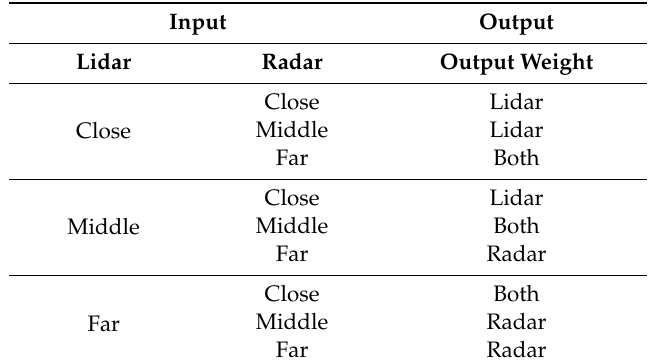
Table 2. Fuzzy rules.